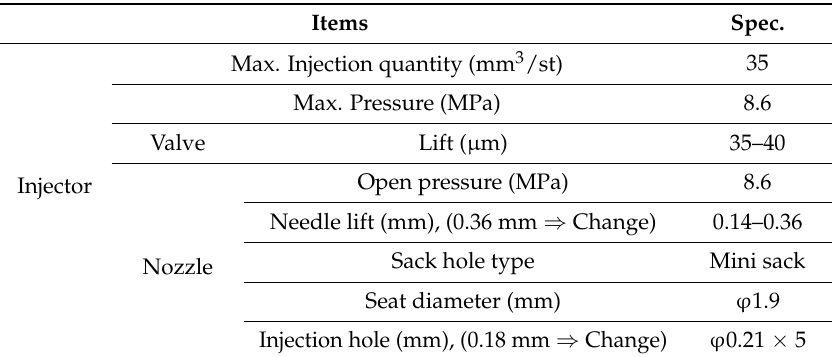
Table 2. Common rail specification of injection system.